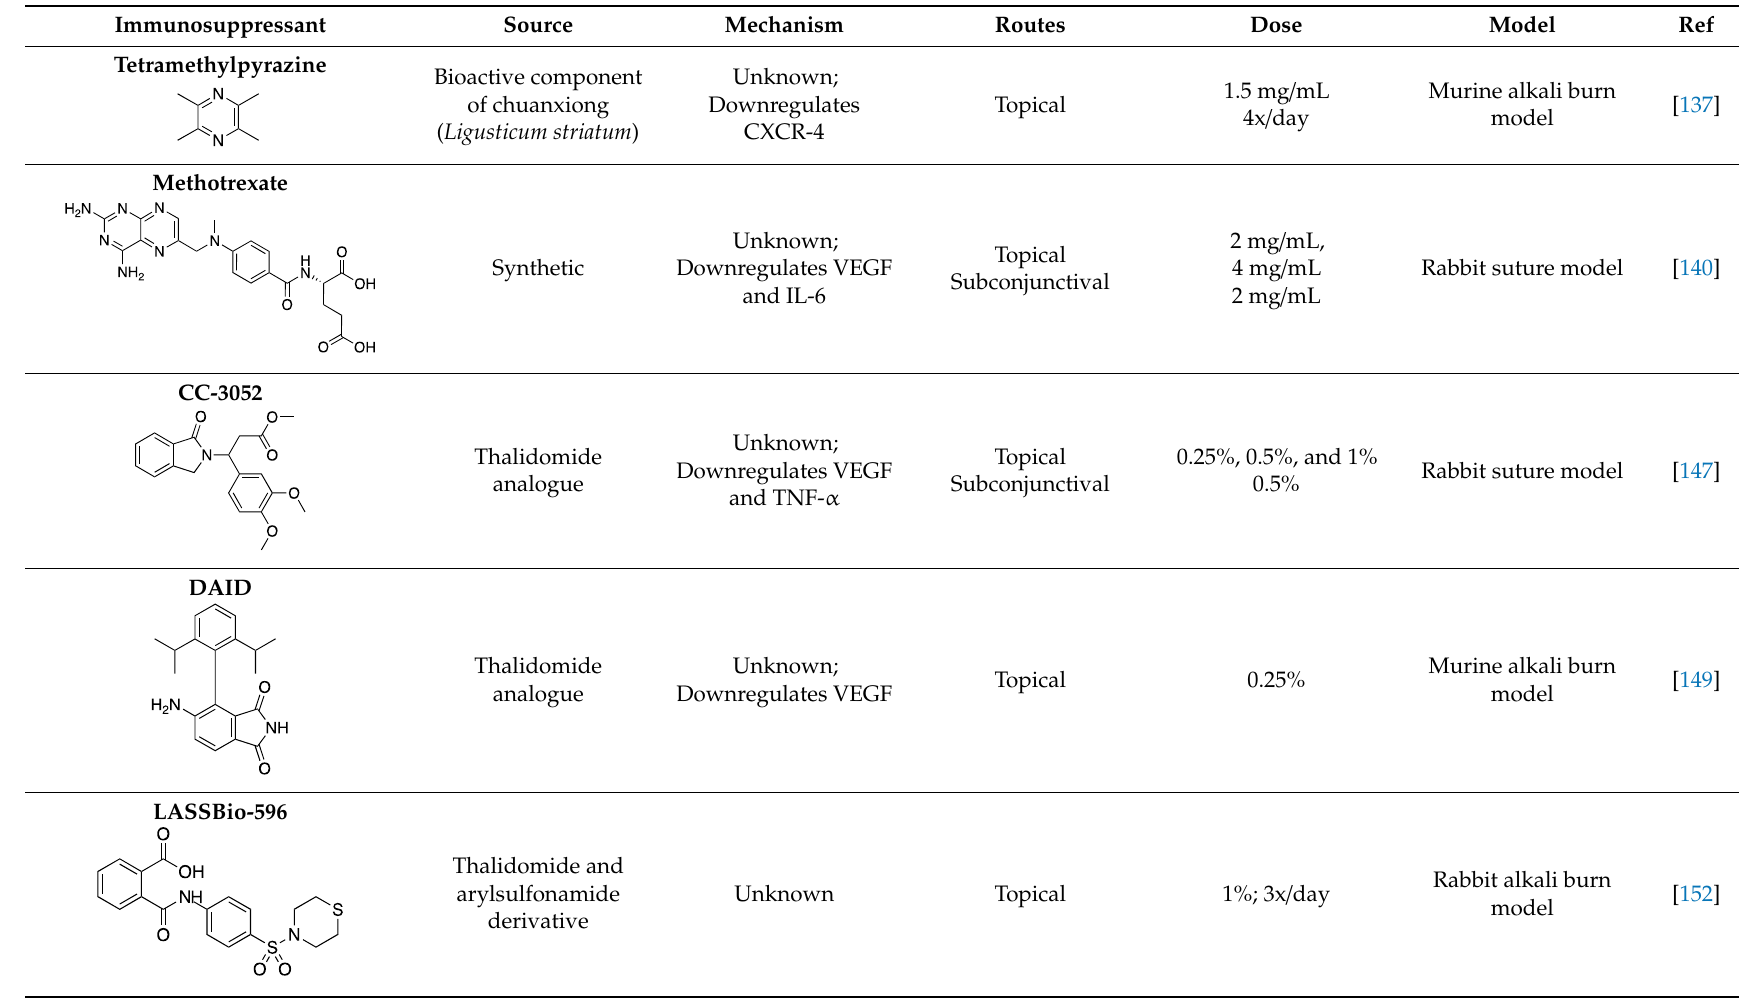
Table 6. Immunosuppressants, including macrolides, tested in CoNV models.